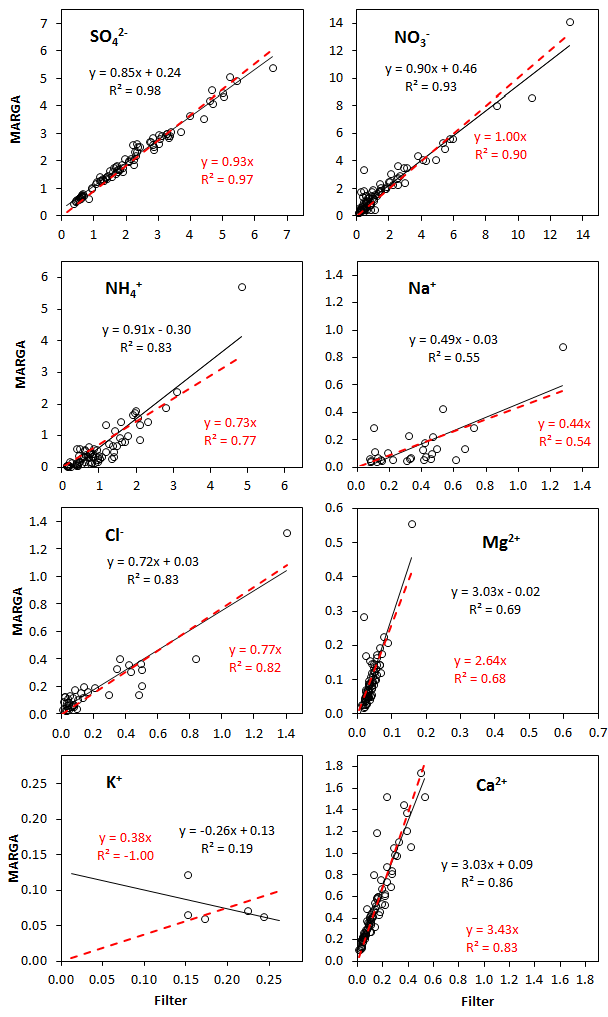
Fig. 3. Comparisons of concentrations of ions in the size range D p < 10µm measured with the MARGA and analyzed from Teflon filters. The MARGA data were averaged over the filter sampling periods. Unit: µgm − 3 . The linear regressions with the black lines and equations were calculated by fitting both slopes and offsets and those with the red dashed lines and red equations by forcing the offset to zero.